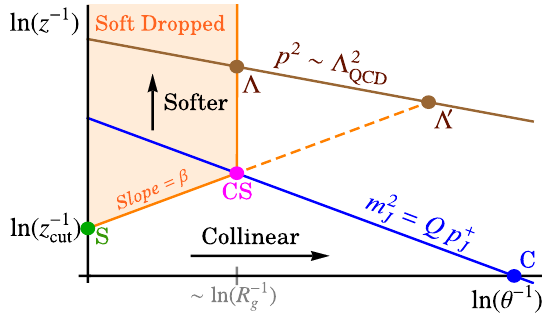
Figure 4 . Comparison of the leading nonperturbative (cid:3) mode and a subleading (cid:3) 0 mode in the SDOE